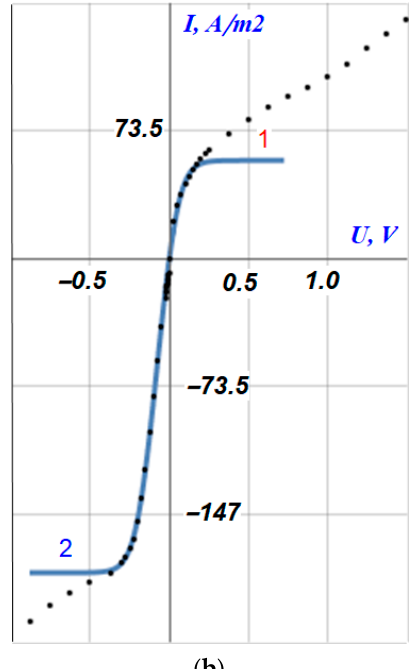
Figure 5. Asymmetrical current–voltage curves of bilayer composite membrane MF-4SC/PTMSP in 0.05 M solution of NaCl ( a ) and HCl ( b ): 1, s—orientation of the layer 1 (PTMSP) of the composite to the anode (towards the counter-ion flux); 2, w—orientation of the layer 2 (MF-4SC) of the compo- site to the anode; points—experiment; curves—theory.